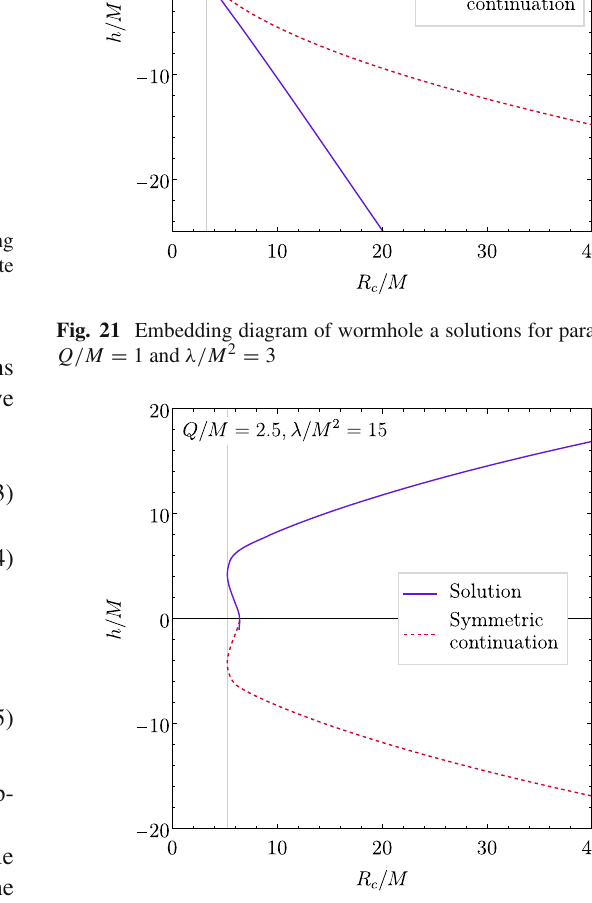
Fig. 22 Same as Fig. 21 for Q / M = 0 . 5 and λ/ M 2 =